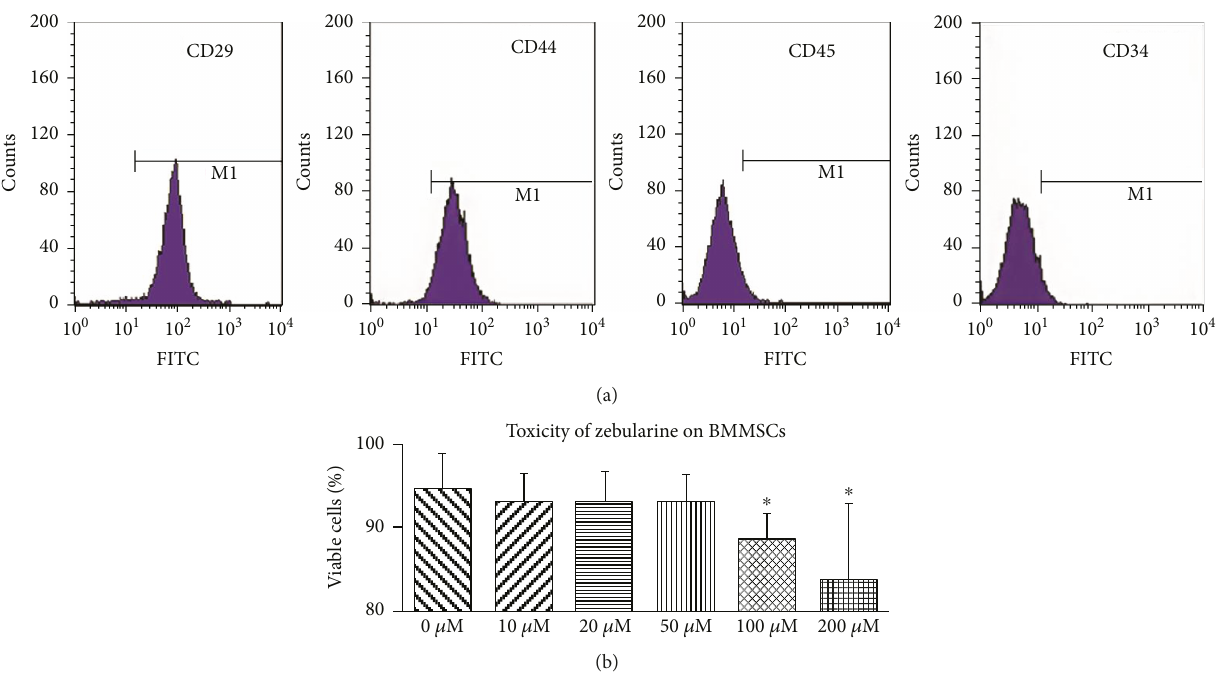
Figure 1: Positive expression rates of BMMSC surface marker antigens CD29, CD44, CD45, and CD34 and toxicity of zebularine on BMMSCs. Asterisk indicates p < 0 05 compared with the 0 μ M